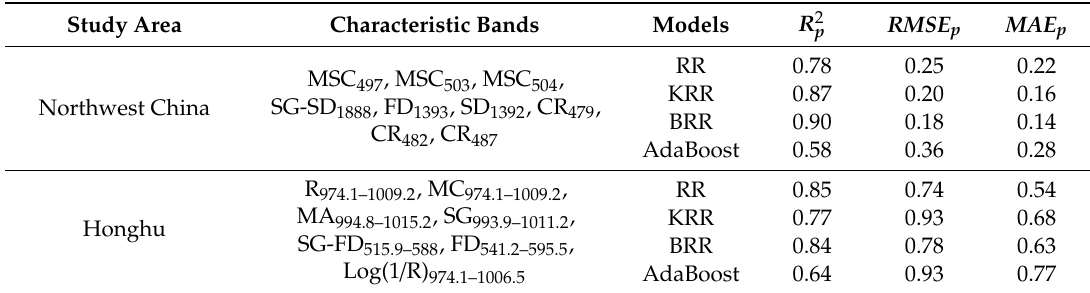
Table 3. Results of the quantitative inversion models of SOM.